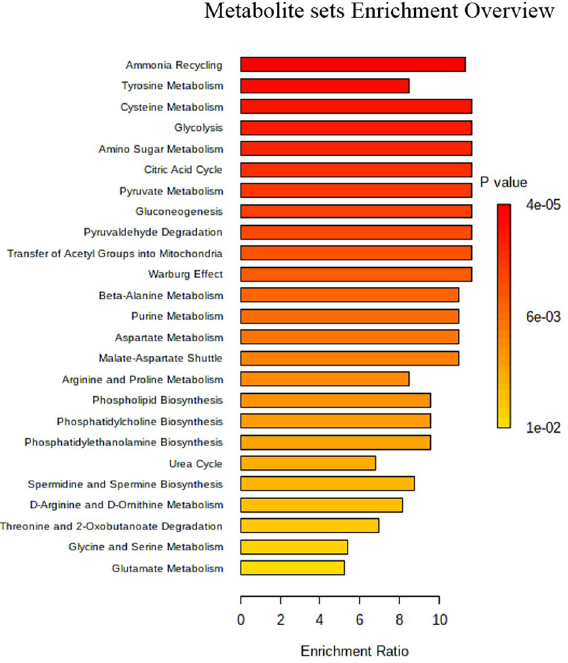
Figure 3. Enrichment analysis. List of the most significantly discriminant pathways between IEI-EMF subjects and controls.